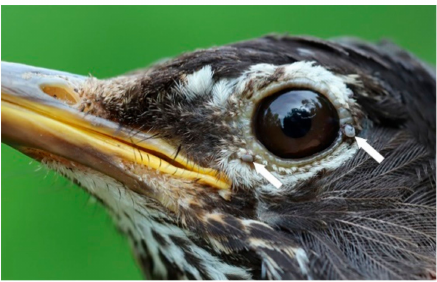
Figure 3. American Robin, second year female, parasitized by four I. scapularis nymphs (two not visible). On 22 July 2019, this bird was in moult in preparation for the upcoming, southbound, fall migration. Photo credits: Simon